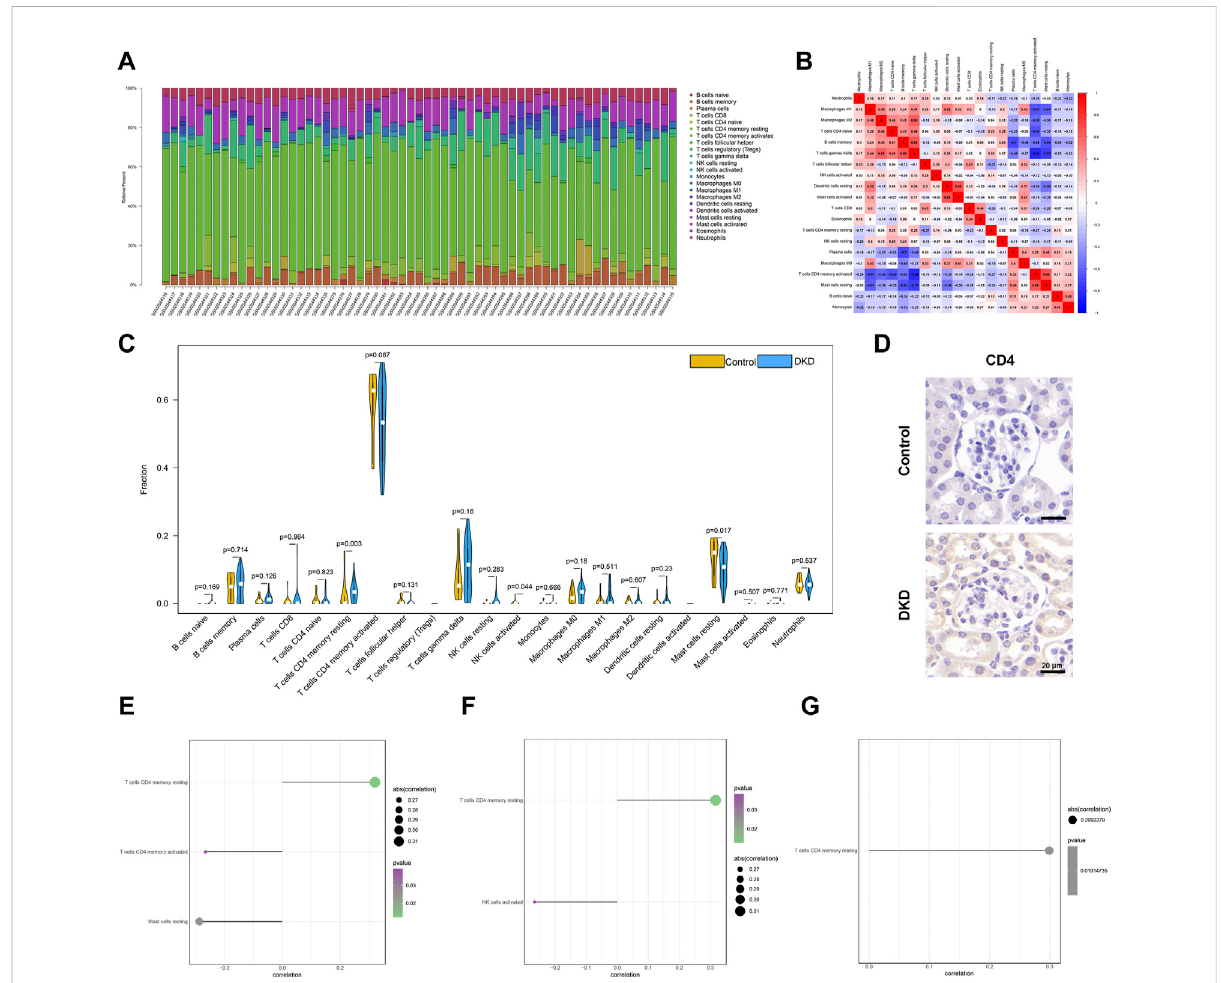
FIGURE 7 Immune in fi ltration of all samples. (A) Relative percentages of 22 immune cell subsets across all samples. (B) Pearson correlations between 22 immune cells. Blue and red indicate positive and negative correlations, respectively. (C) Differences in immune cell content between normal patients(yellow)andpatientswithDKD(blue). p < 0.05isconsideredstatisticallysigni fi cant. (D) RepresentativeIHCstainingofCD4inthecontroland DKD groups. (E – G) Spearman correlations of OAS1, SECTM1, SNW1 gene expression and immune cell